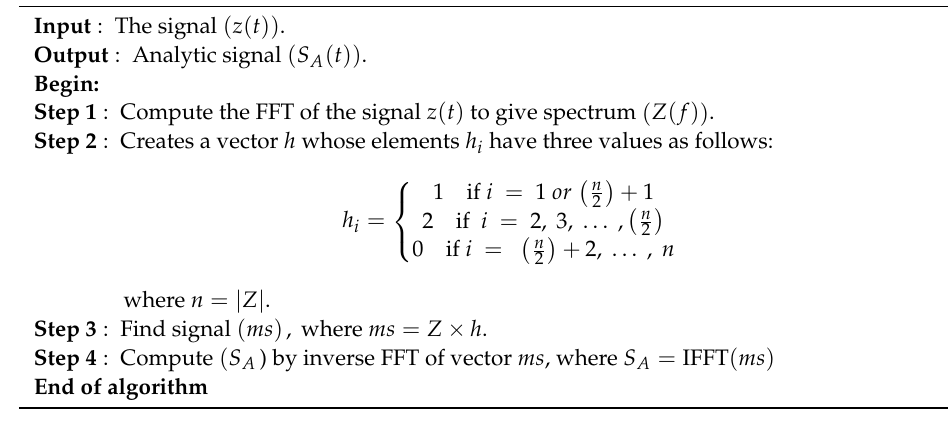
Algorithm A2: Hilbert Transform